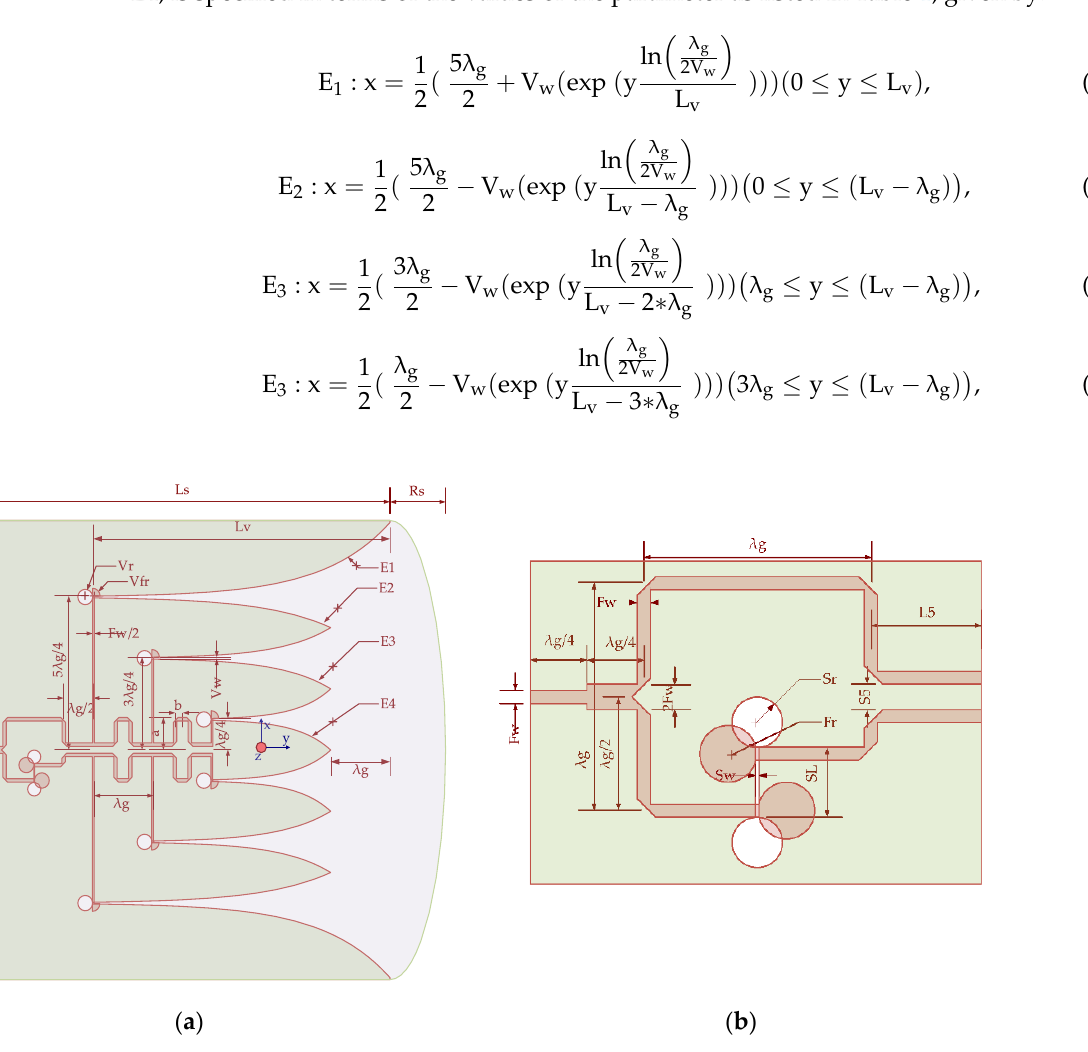
Figure 1. Structure of antenna: ( a ) top view of the antenna presenting feed, substrate, and ground layer structure; ( b ) enlargement of the feeding top view section of an antenna from Figure 1a. Table 1. Parametric dimensions of the proposed antenna